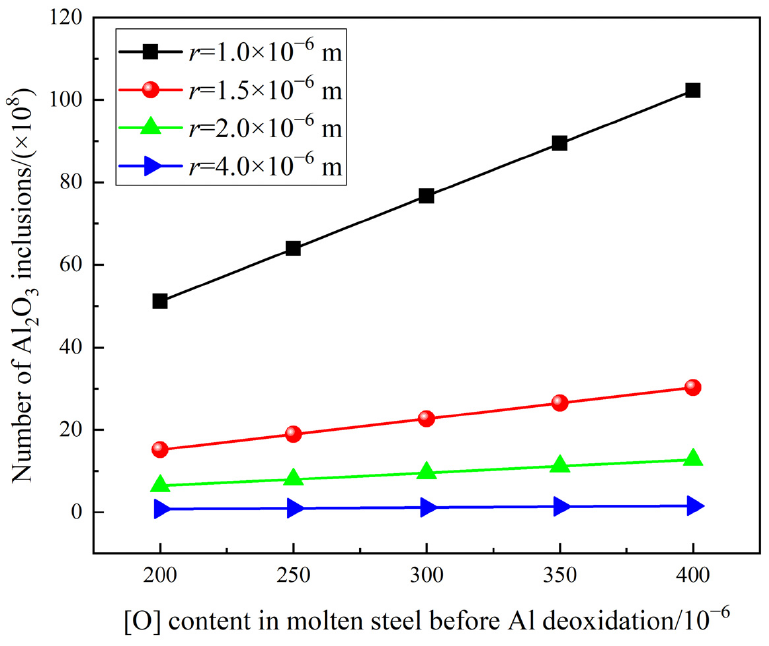
Figure 17. Relationship between the number of Al 2 O 3 inclusions and [O] content in molten steel before Al deoxidation.